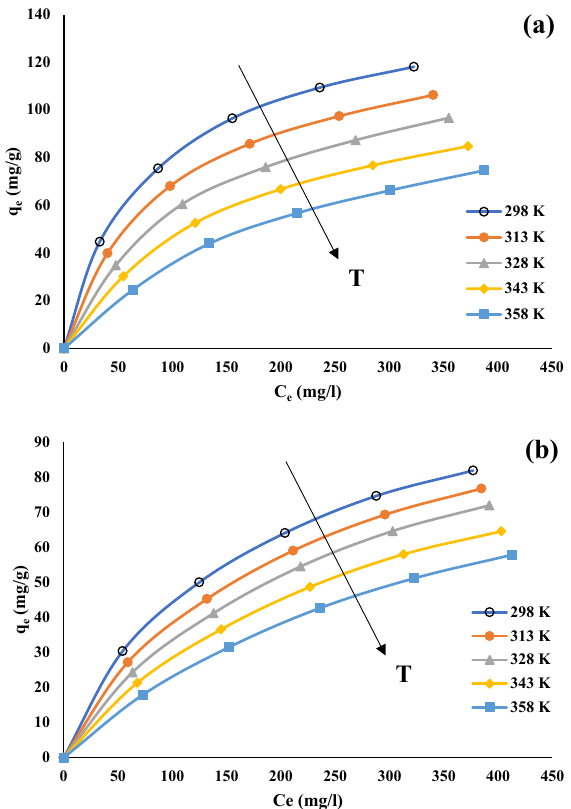
Figure 5. Influence of temperature on phenol adsorption isotherms onto ( a ) MSAC and ( b ) pristine activated carbon (Initial phenol concentration = 100 mg/L, pH = 7 and adsorbent dosage = 1.5